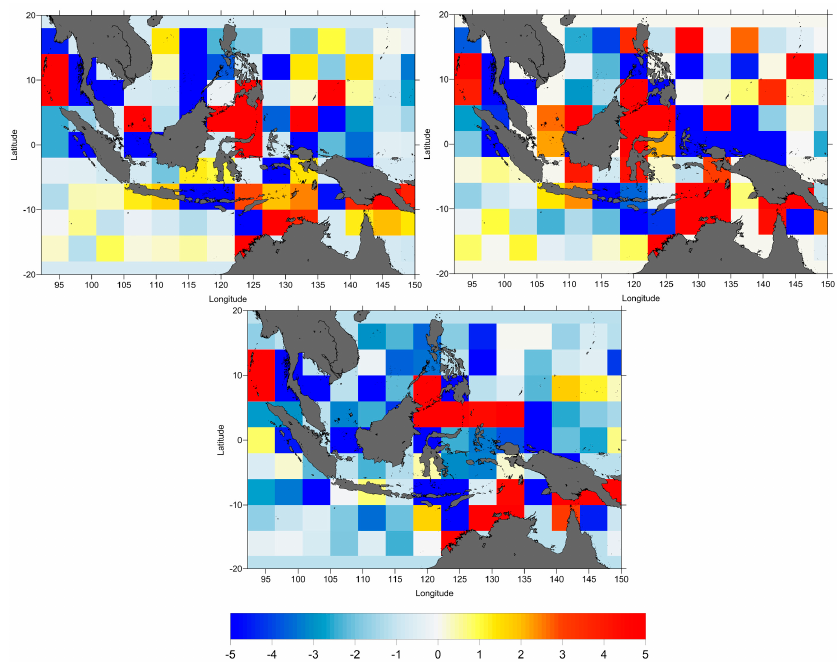
Figure 15. SLA variance differences (cm 2 ) function of distance from the coast between GOT4.10 and FES2012 tide models for TOPEX cycles 1 to 364, Jason-1 cycles 1 to 259 and Jason-2 cycles 1 to 280.